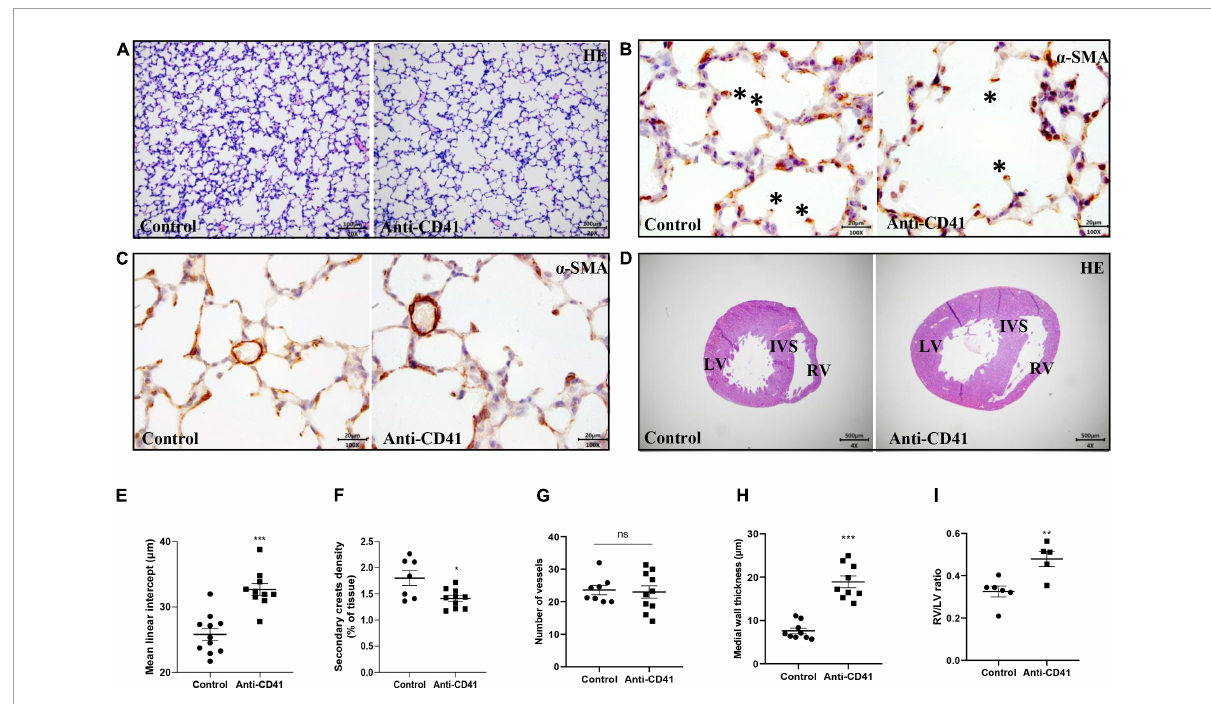
FIGURE2 Platelet depletion impaired lung alveolarization and caused vascular remodeling but did not affect angiogenesis in neonatal mice. Representative images of hematoxylin-eosin (HE, A ) and α -smooth muscle actin ( α -SMA, B,C ) stained lungs from pups treated with anti-CD41 antibody or isotype. Representative images of HE-stained hearts taken halfway the long axis (D) . Quantification of mean linear intercept (MLI, E ), secondary crest density corrected for tissue area (F) , number of vessels (G) , medial wall thickness (H) and right ventricular hypertrophy (RVH, I ). Data are expressed as mean ± SEM, ** p < 0.01. *** p < 0.001. Asterisks indicate secondary